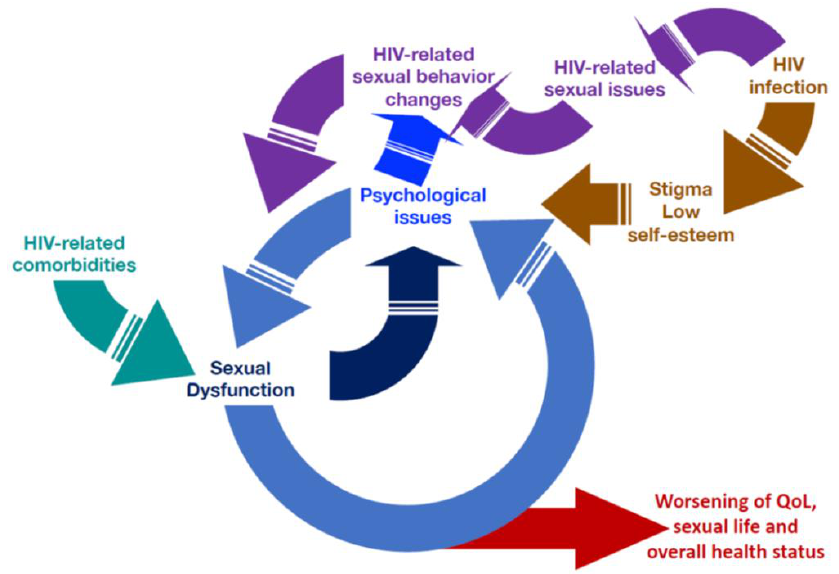
Figure 1. The vicious circle of sexual dysfunction, psychosexual issues, HIV infection and related morbidities and overall health status in men living with HIV. Abbreviations: QoL: Quality of Life. Table 1. Specific factors that influence sexuality in human immunodeficiency virus (HIV)-infected